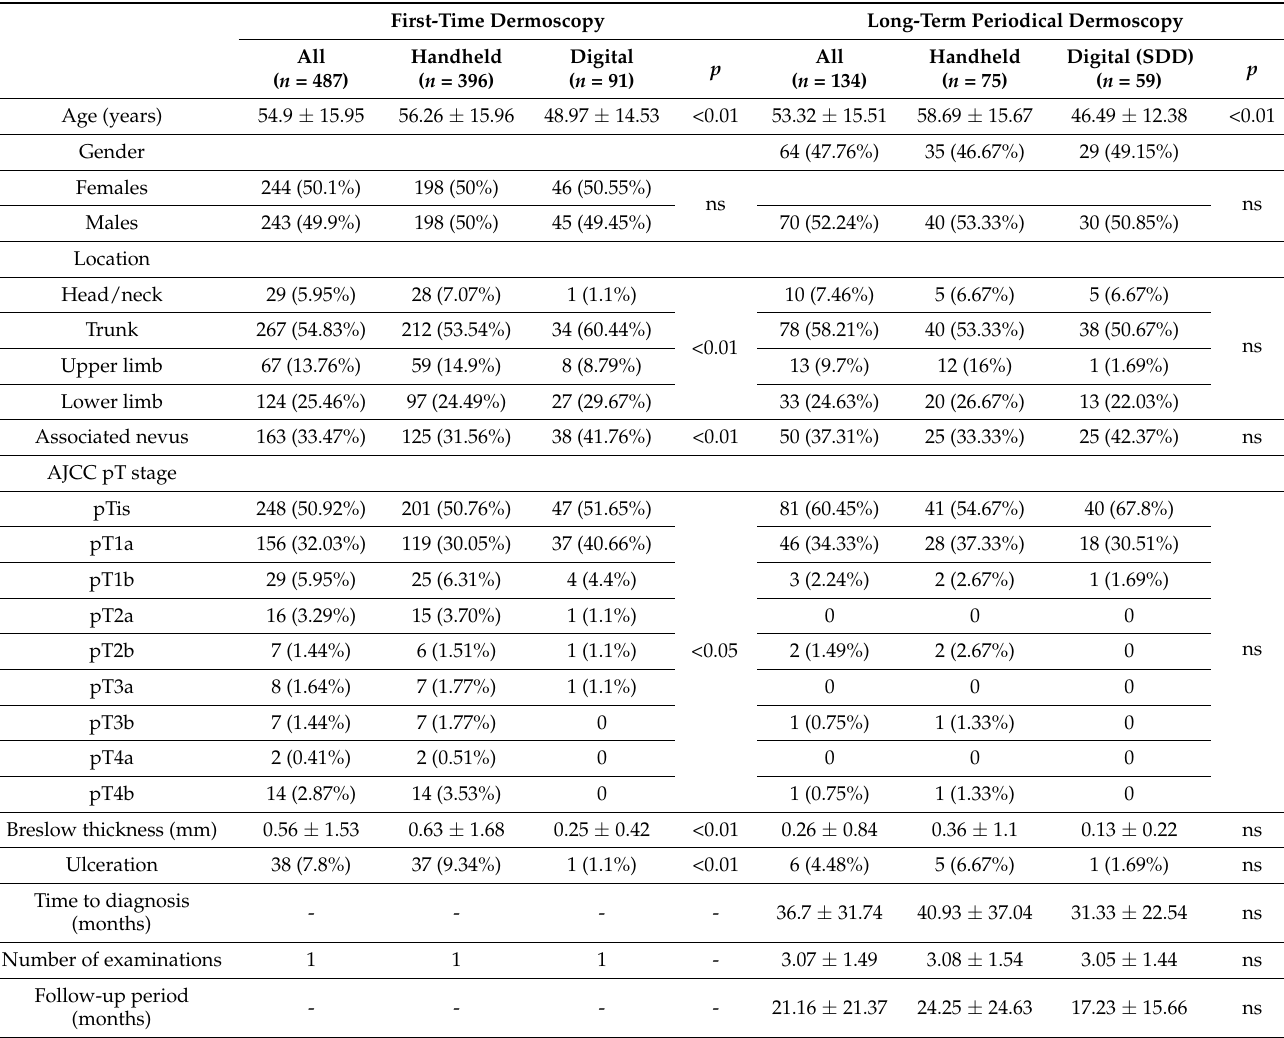
Table 2. Demographic, clinical, and histopathological data of melanomas diagnosed by first-time and periodical dermoscopy. ns,